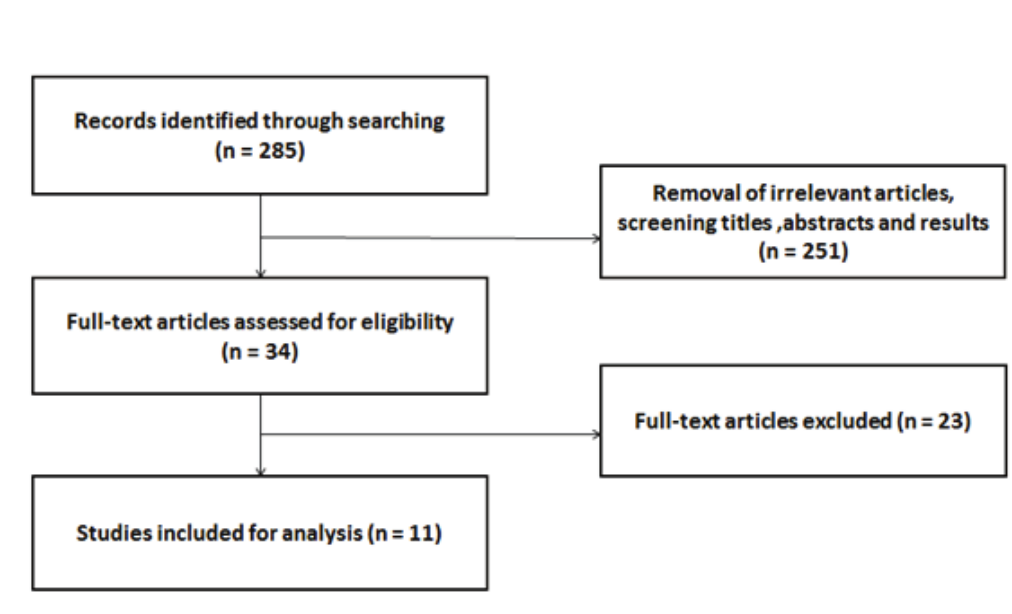
Figure 1: The flow diagram for the process of study selection and systematic review of literature.